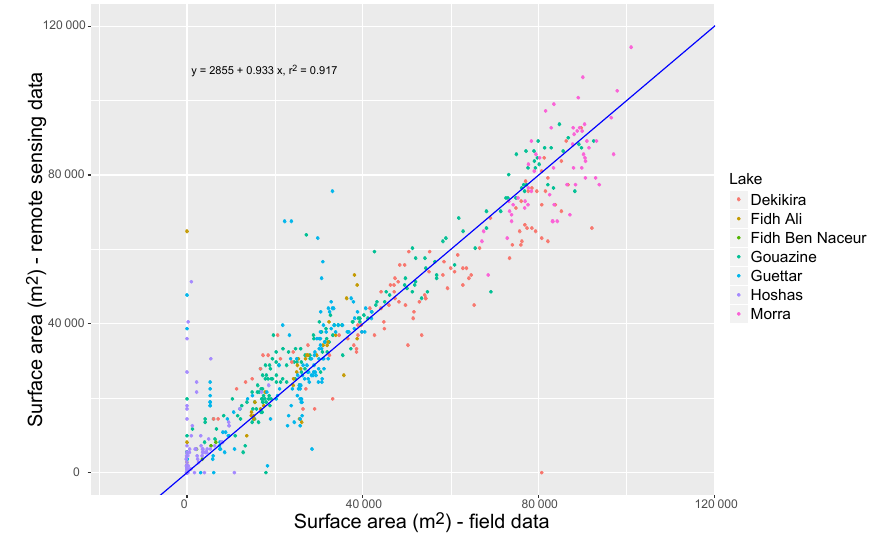
Figure 13. Remotely sensed surface areas with the MNDWI on Landsat imagery vs. field data over 1999–2014 across all seven